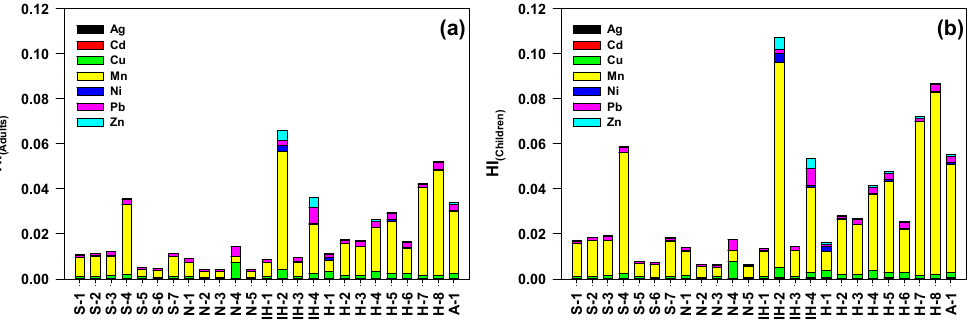
Figure 9. Variation of hazard index (HI) values for ingestion and dermal absorption in children ( b ) and adult ( a ) population groups in the Han River Watershed.